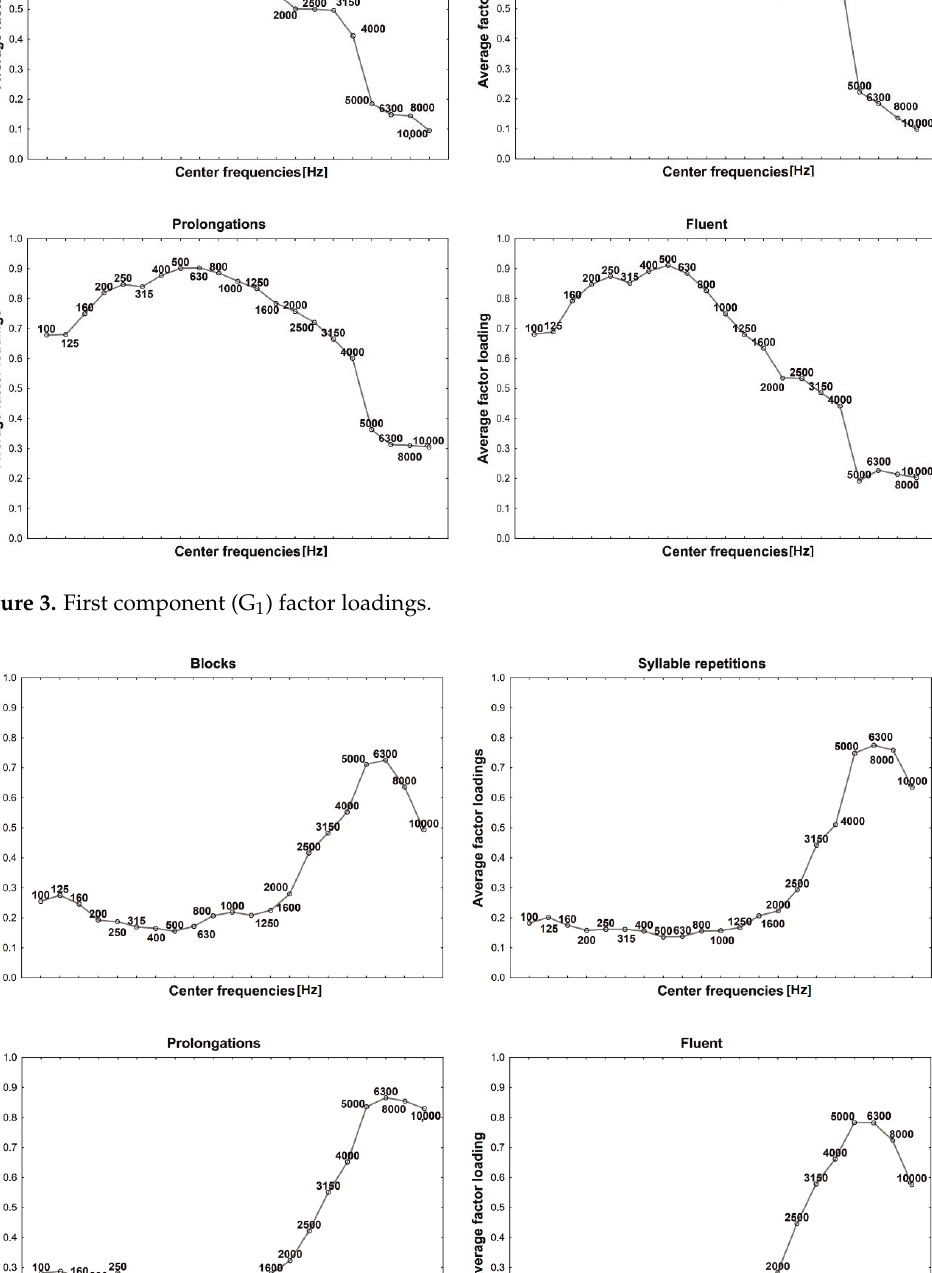
Figure 5. Prolongation spectrogram with G 1 (red) and G 2 (black) components. As can be observed, the shape of both G1 and G2 reflects the general time-frequency structure of the analysed utterance, but it is G2 which reflects higher frequencies while G1 concentrates on the lower ones instead.